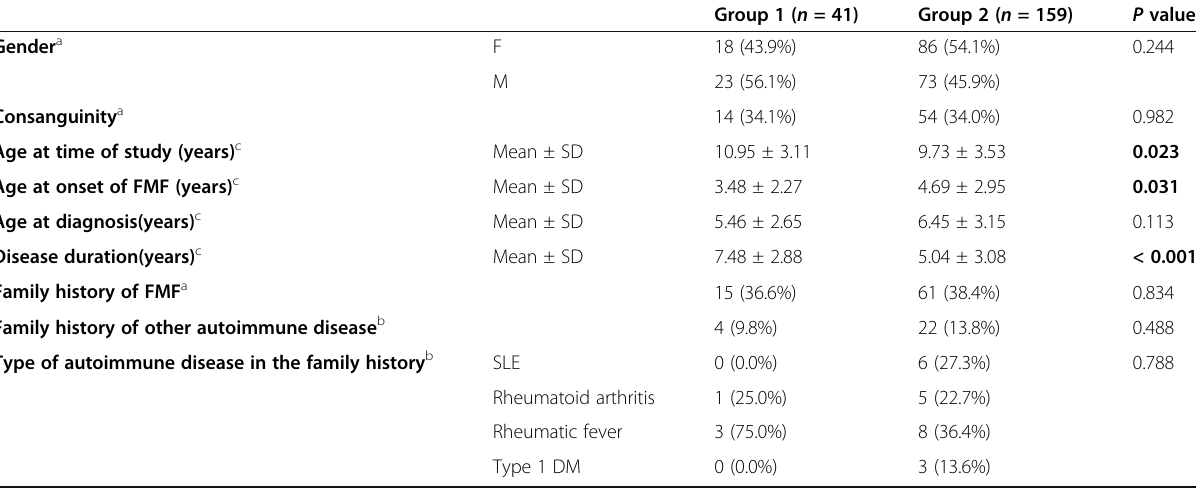
Table 3 Comparison between group 1 and group 2 patients as regard to age, gender, consanguinity, disease duration, and family history showing results as p value